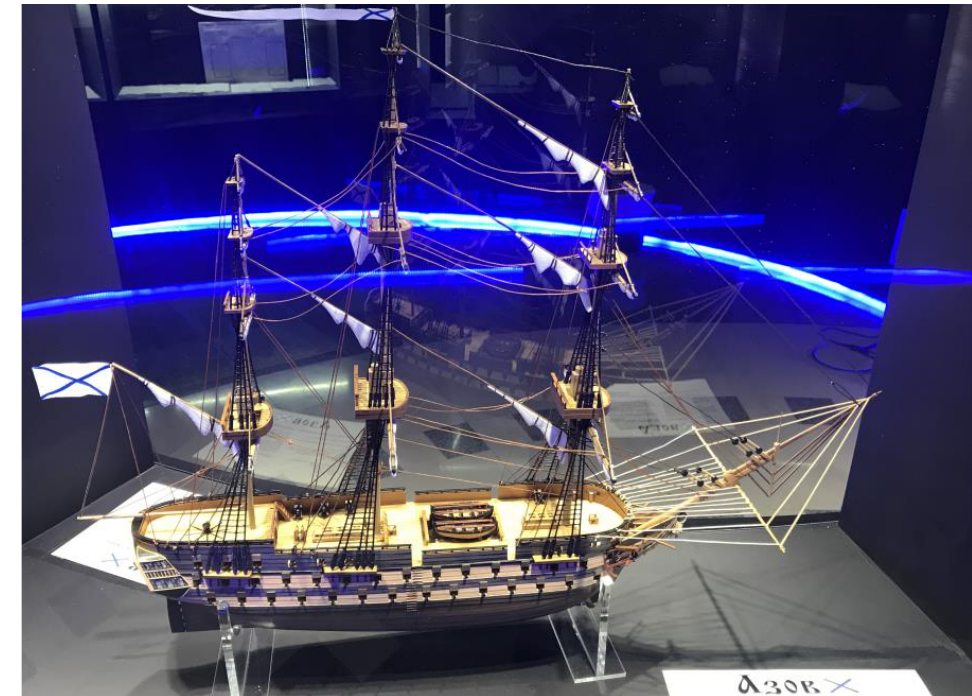
Figure 23 . Azov 3D printed model after painting process.